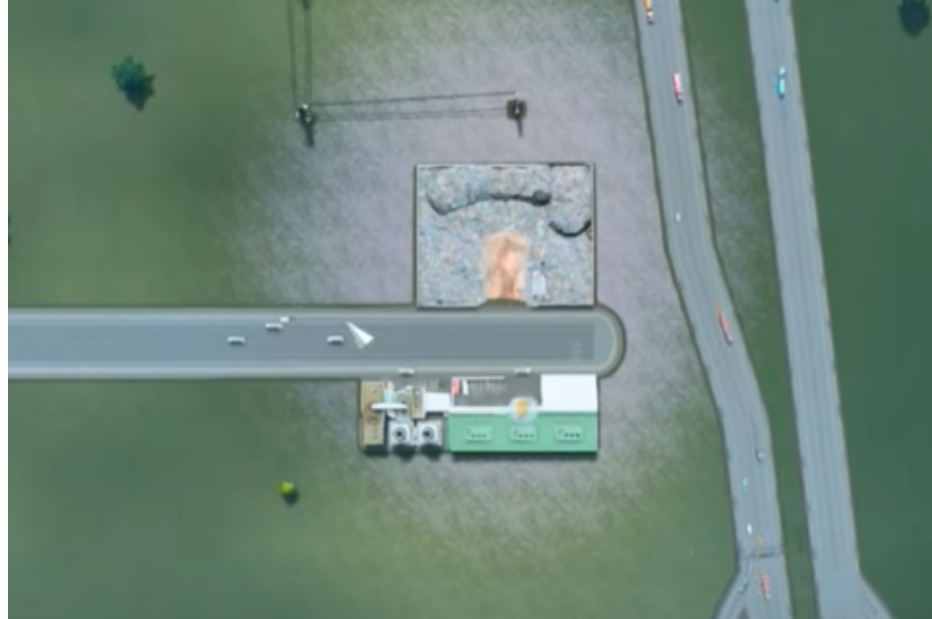
Figure 2. The Recycling Center, Incineration Plant, and Landfill Site are among the waste management options available to players of Cities: Skylines